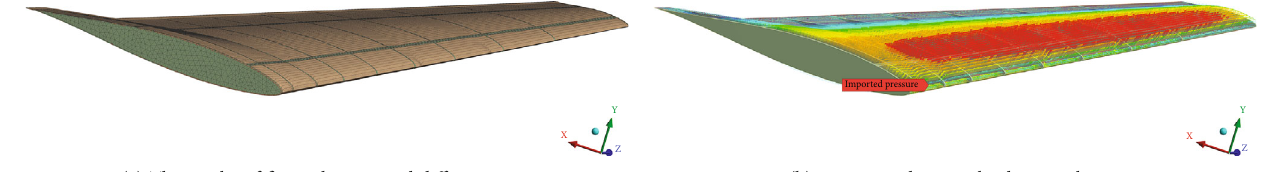
Figure 9: Mesh partitioning and aerodynamic interpolation